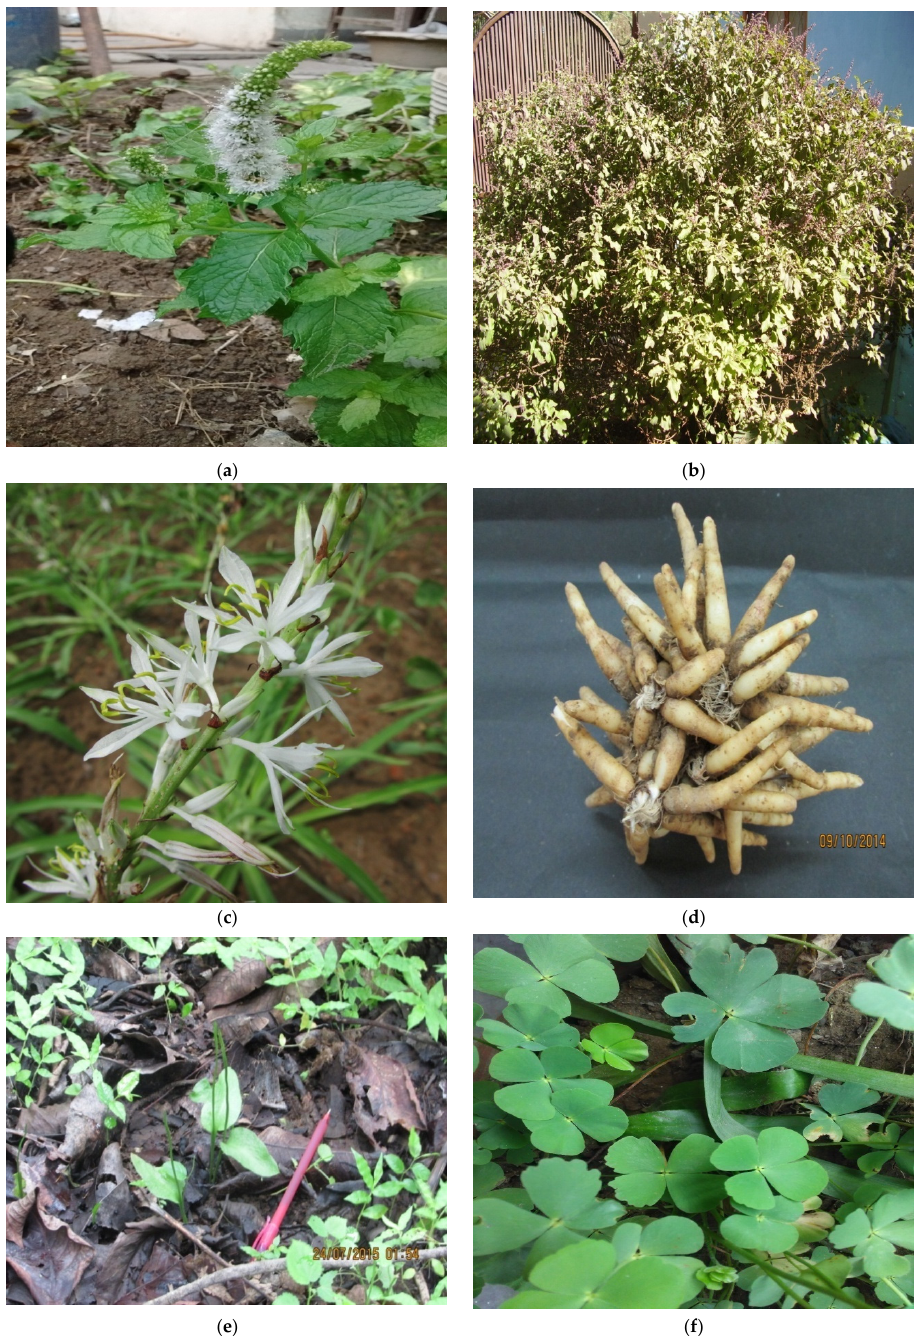
Figure 4. Herbaceous edible plants (mostly leaves): ( a ) Mentha spicata ; ( b ) Ocimum sanctum ; ( c ) Chlorophytum tuberosum with flower; ( d ) Roots of Chlorophytum tuberosum ; ( e ) Ophioglossum reticulatum; ( f ) Marsilea minuta.